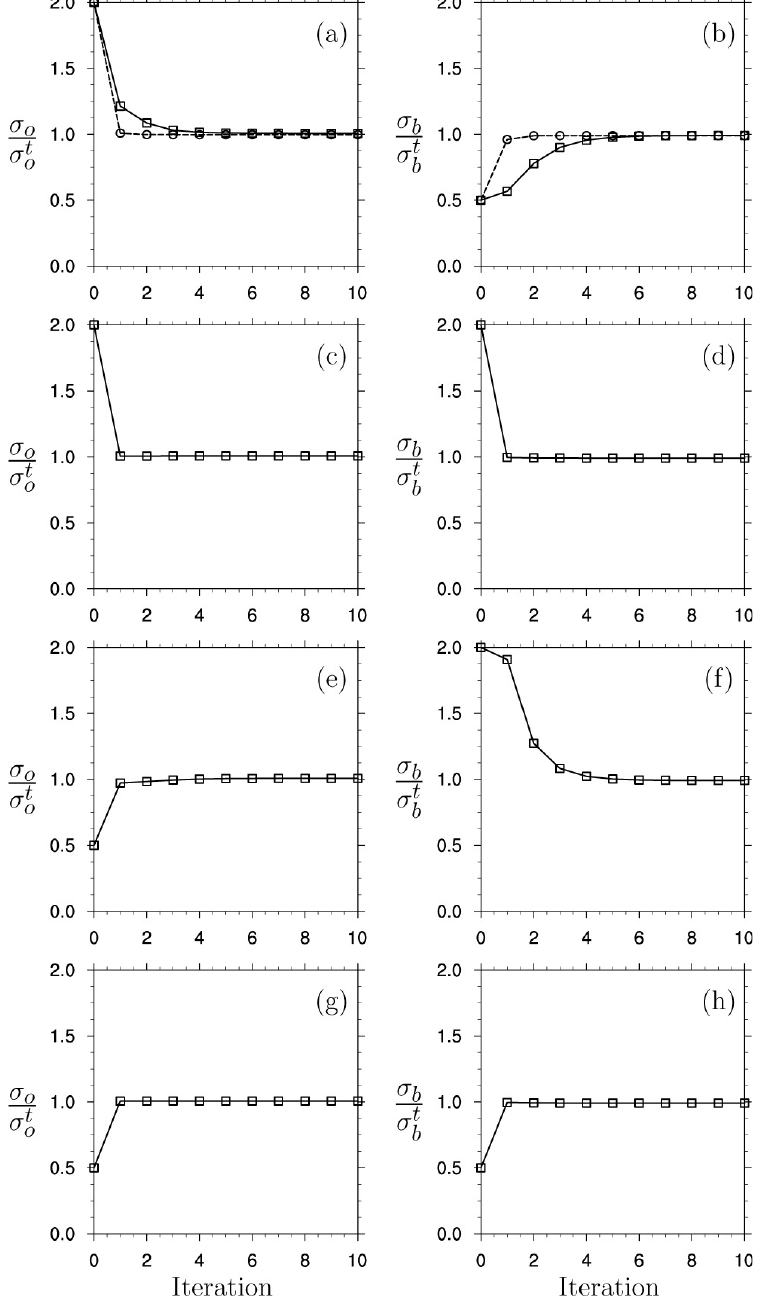
Fig. 5. Iterative tuning of multiplicative coefficients for the error covariance matrices. σ o (left) and σ b (right) are tuned simultaneously with (a, b) overestimated σ o , underestimated σ b ; (c, d) overestimated σ o and σ b ; (e, f) underestimated σ o and overestimated σ b ; (g, h) underestimated σ o and σ b = . Solid lines and square marks: iterative tuning following DI01’s approach; dashed lines and circle marks: new approach (shown only in a, b ). Traces are estimated with the randomization method using 100 independent